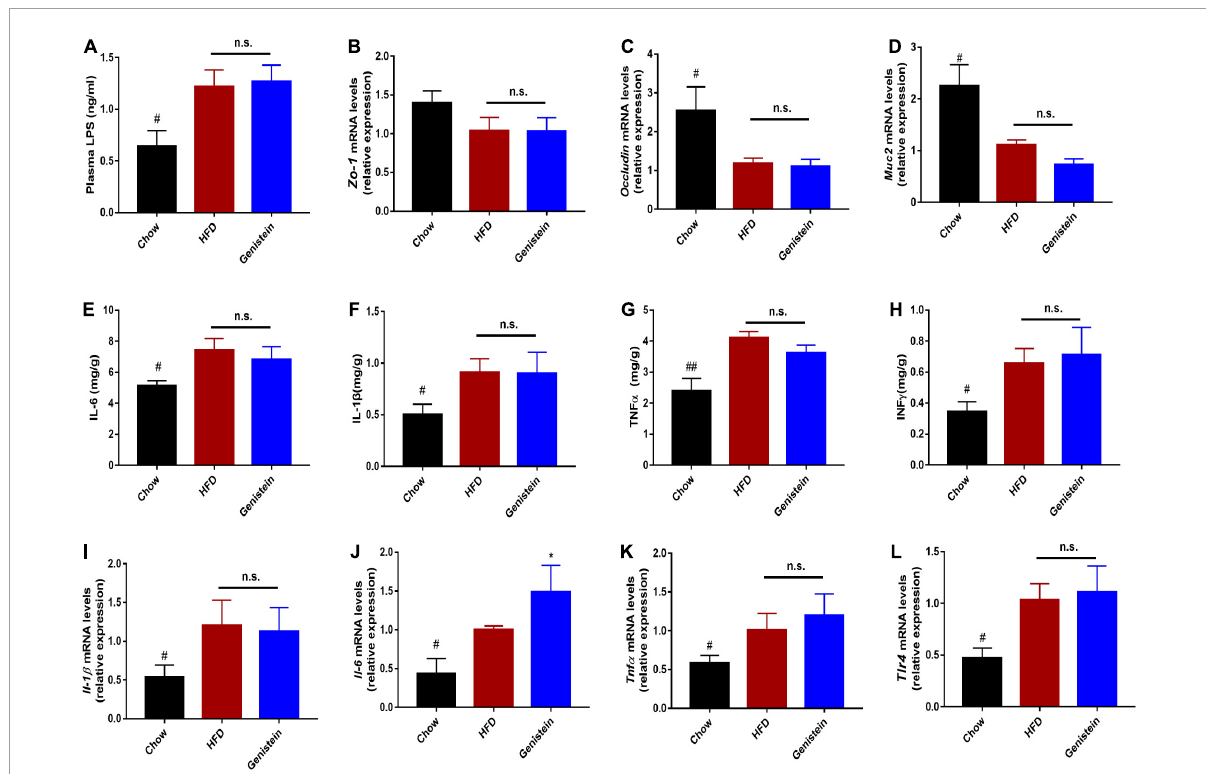
FIGURE7 Genistein has limited effects on intestinal permeability and markers of liver inflammation (A) Plasma LPS level. (B–D) qRT-PCR mRNA analysis of Zo-1 , Occludin, and Muc2 in colon of mice. (E–H) Inflammatory cytokines levels in colon tissues. (I–L) qRT-PCR mRNA analysis of Il-1 β , Il-6 , Tnf- α and Tlr4 in liver of mice. Data are presented as means ± SEM; n = 4–5 mice/group. # p < 0.05 and ## p < 0.01 for Chow vs. HFD. * p < 0.05 for Genistein vs.